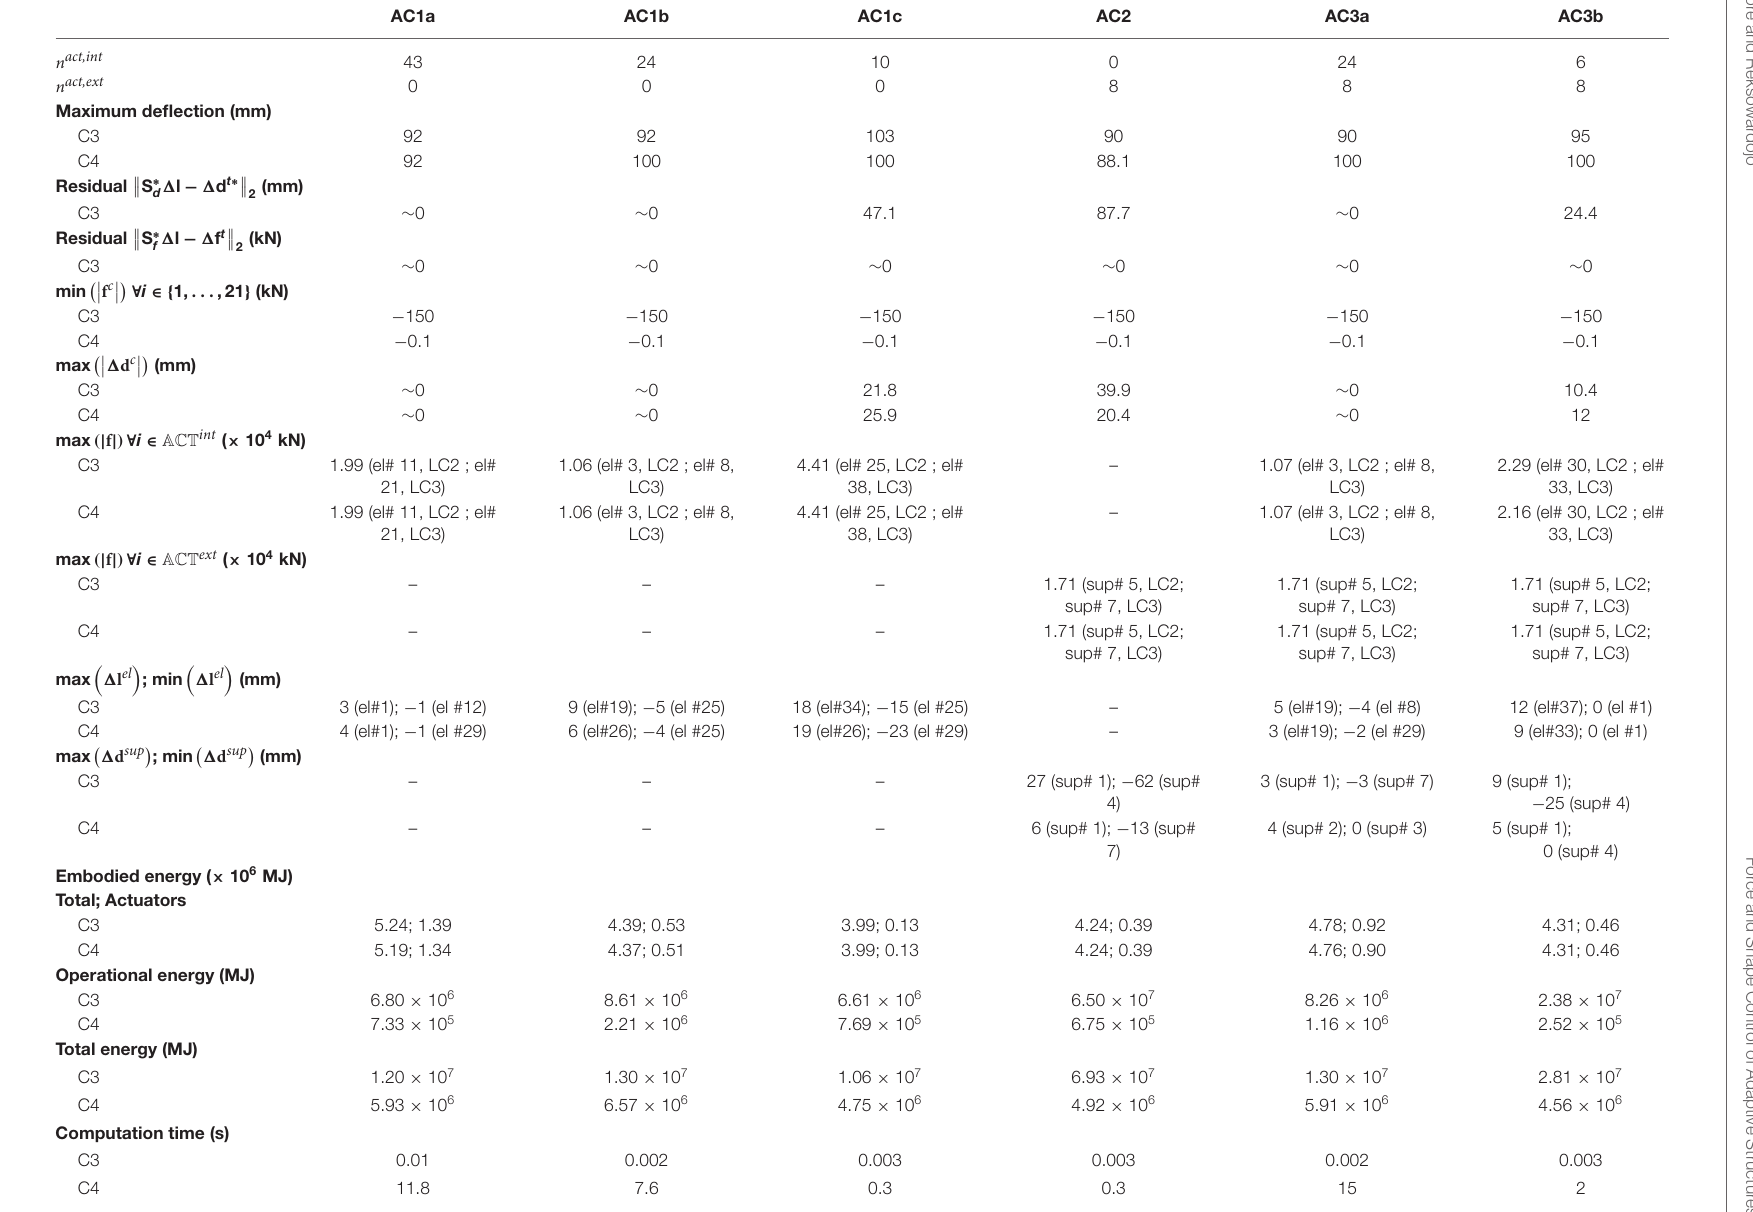
TABLE 9 | Arch bridge: summary of